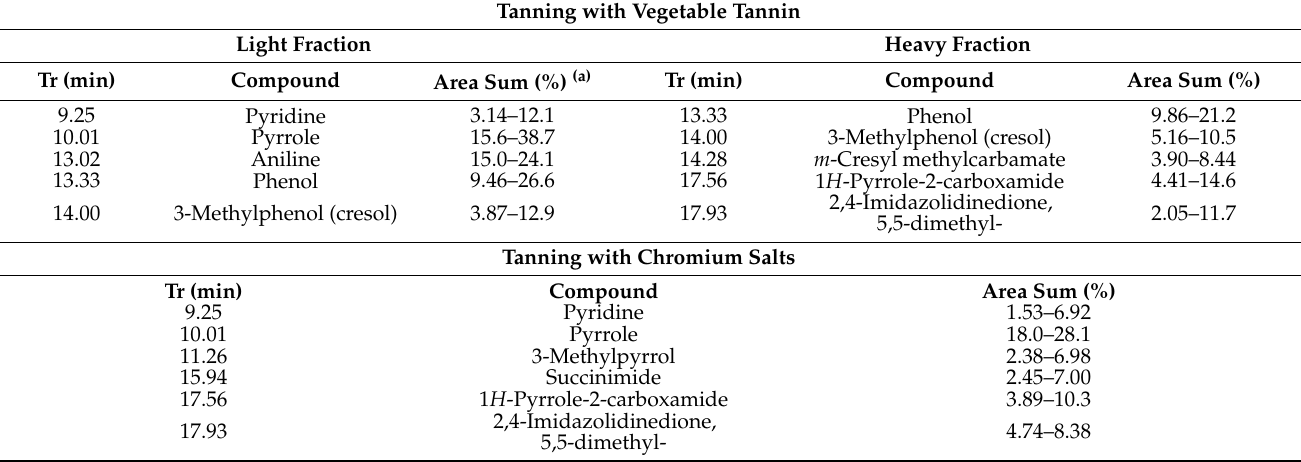
Table 2. Composition of the liquid fraction by CG-MS.